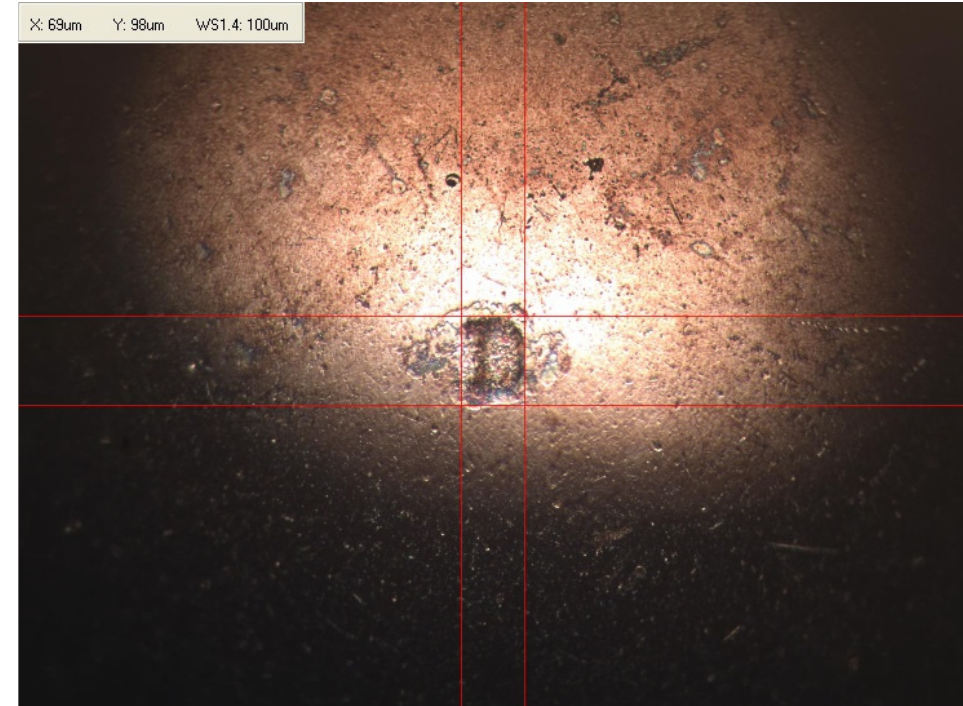
Figure A6. SAE 30—80% m/m; DO—20% m/m.